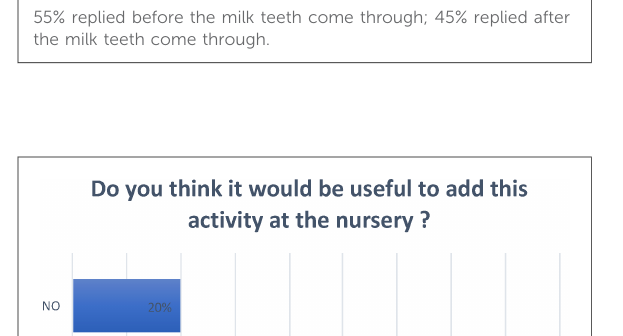
FIGURE 6 If a program is in place, what is used?